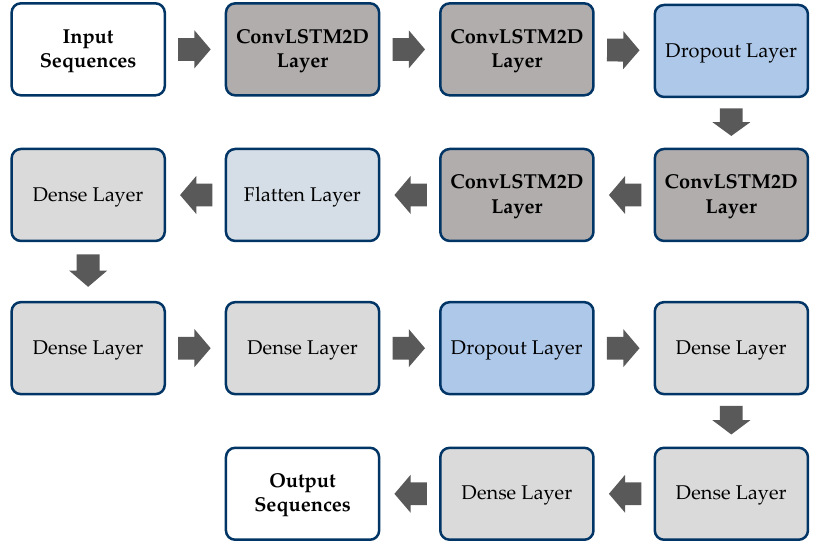
Figure 5. CNN-LSTM Model Structure [53].